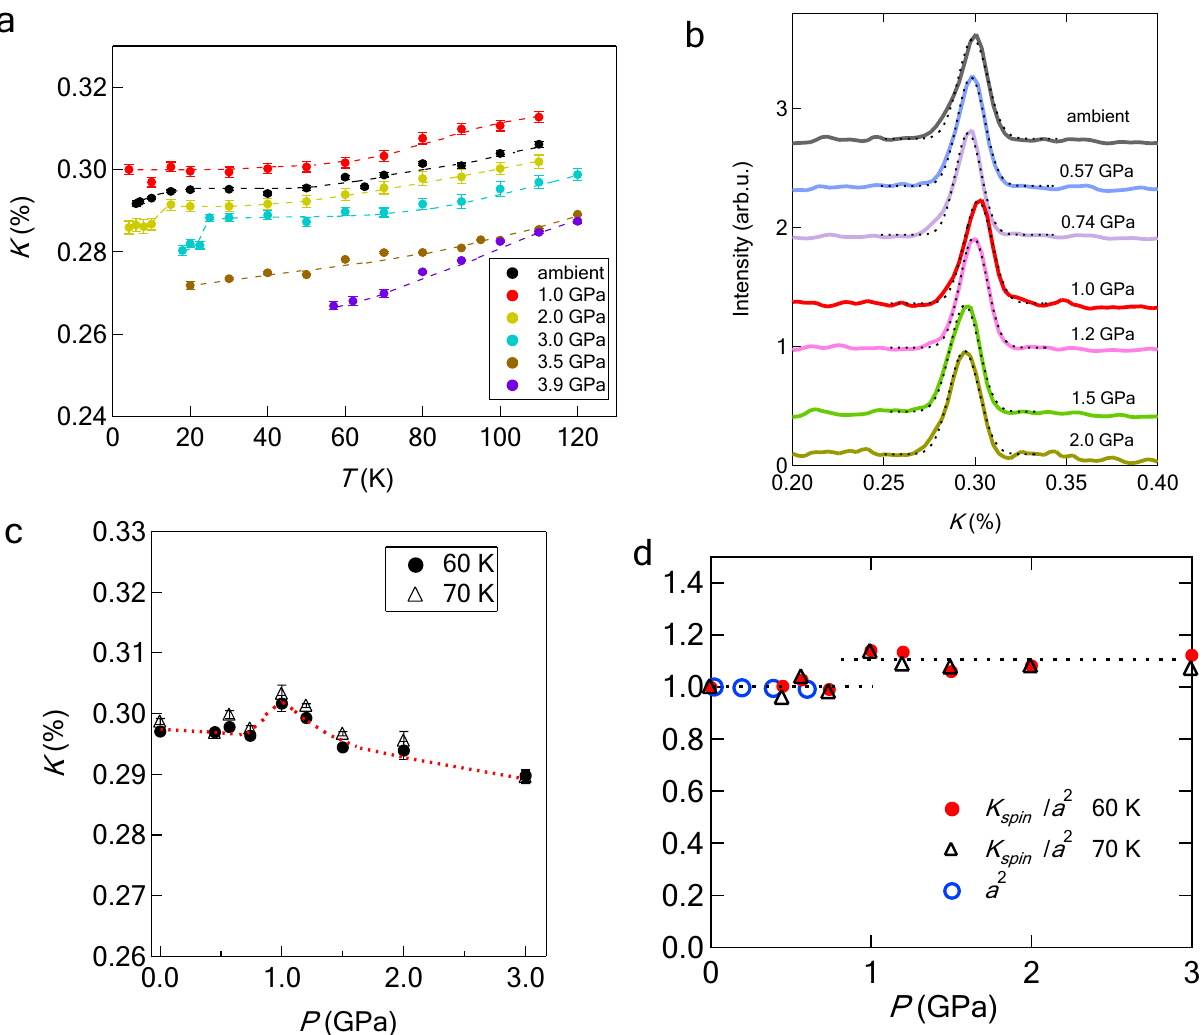
Figure 3. 77 Se-Knight shift for 12% S-substituted FeSe. ( a ) Temperature dependence of Knight shift ( K ) at several pressures. The Knight shift below 3 GPa 20 reflects the density of states (DOS) at low temperatures. The decrease in K due to superconductivity is clearly observed at 2 or 3 GPa. ( b ) Pressure dependence of the NMR spectra at 60 K. Each spectrum is fitted with a Gaussian function, as indicated by dotted curves. ( c ) Pressure dependence of K measured at 60 and 70 K. The dotted curves are guides to the eye. ( d ) Pressure dependence of the square of the a-axis lattice constant ( a 2 ) and K spin / a 2 normalized by those at ambient pressure. The dashed lines represent the average of K spin / a 2 at pressure regions below and above 1